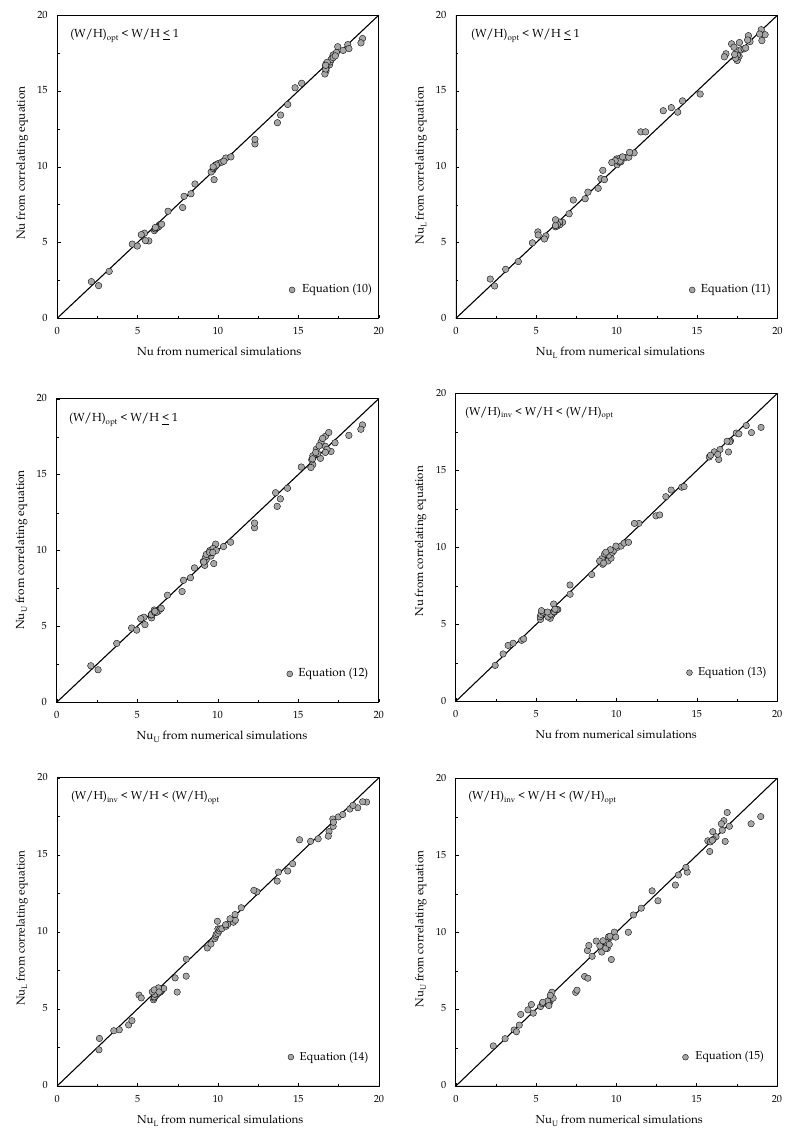
Figure 15. Comparison between Equations (10)–(15) and the numerical data obtained for the Nusselt numbers of the whole system, the lower plate and the upper plate for W